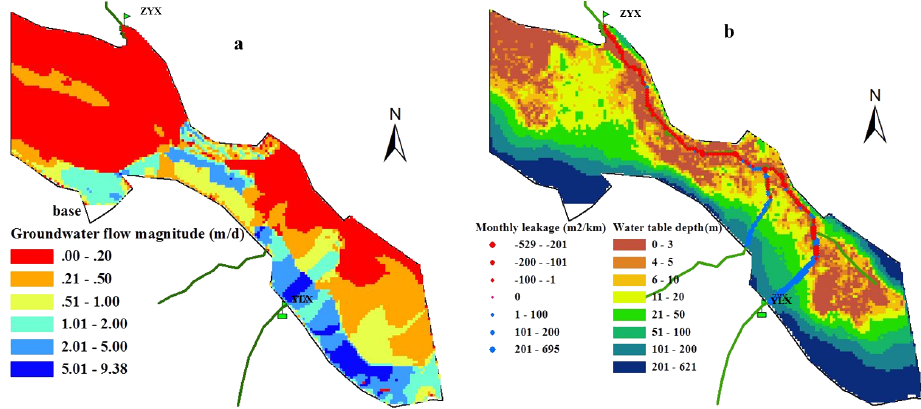
Figure 3. Groundwater flow rate q 0 distribution (a) ; average monthly leakage rate Q b and groundwater table depth (b)